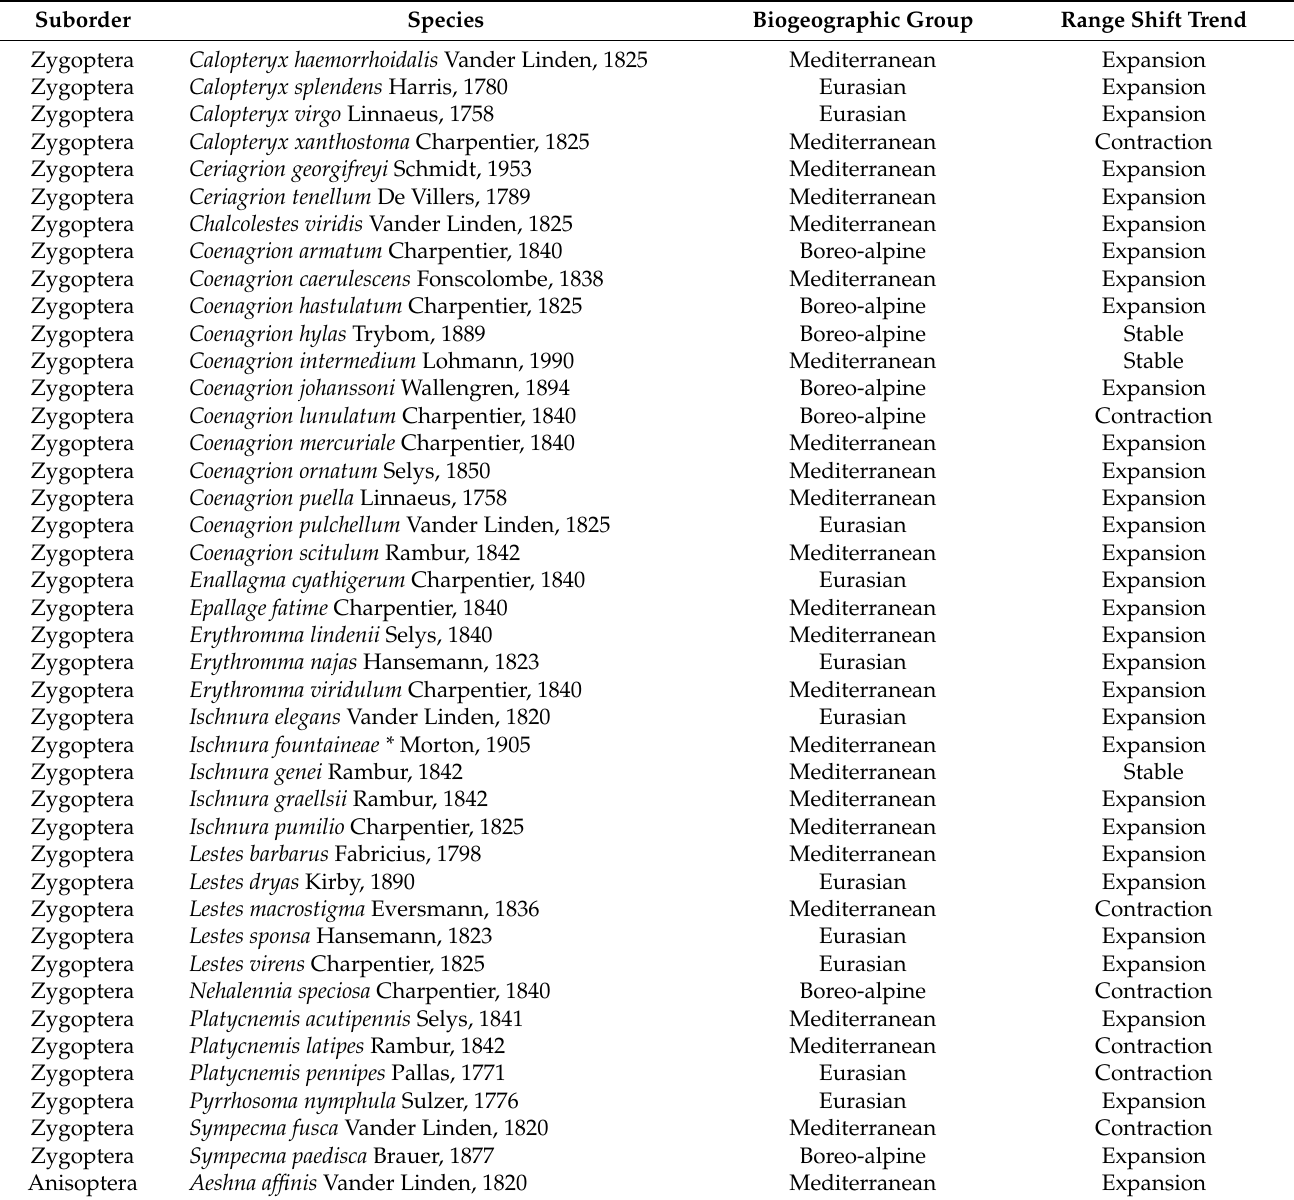
Table A1. List of European dragonfly (Odonata) species ( n = 123) included in the analysis of range shift and changes in species richness 1988–2010 with information on taxonomic suborder, scientific name including author and year of species description, biogeographic group, and range shift trend. * Indicate the four species that in 2010 were included as new in Europe. Nomenclature and taxonomy follow IUCN